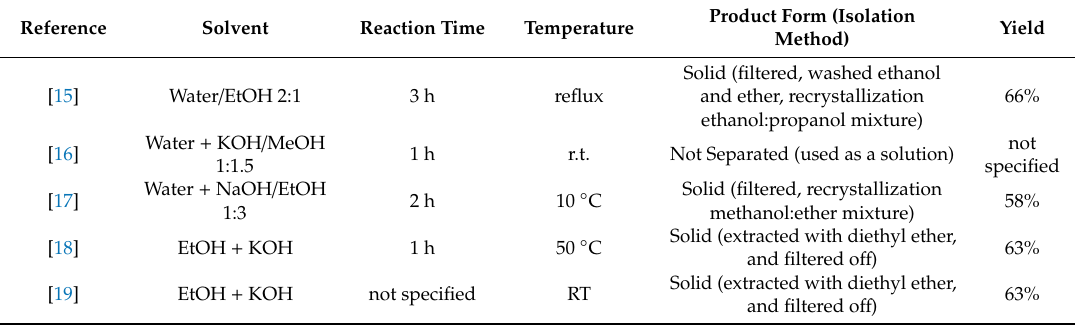
Table 1. Survey of synthesis methods of 1 N -[(2-hydroxyphenyl)methylene]glycine found in the